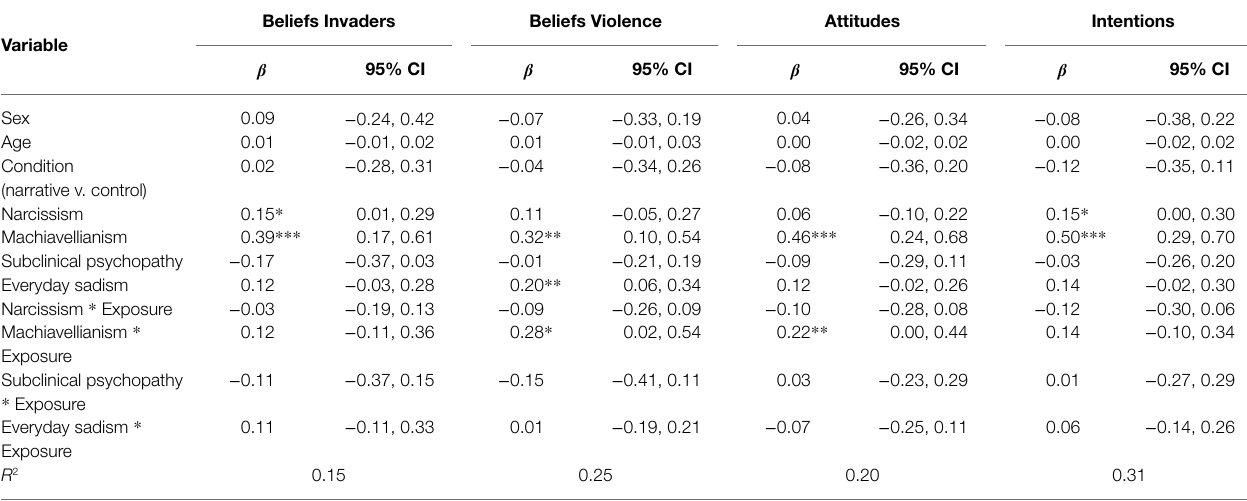
TABLE 4 | Main and interaction effects of dark tetrad traits and narrative exposure on participant beliefs, attitudes, and intentions.